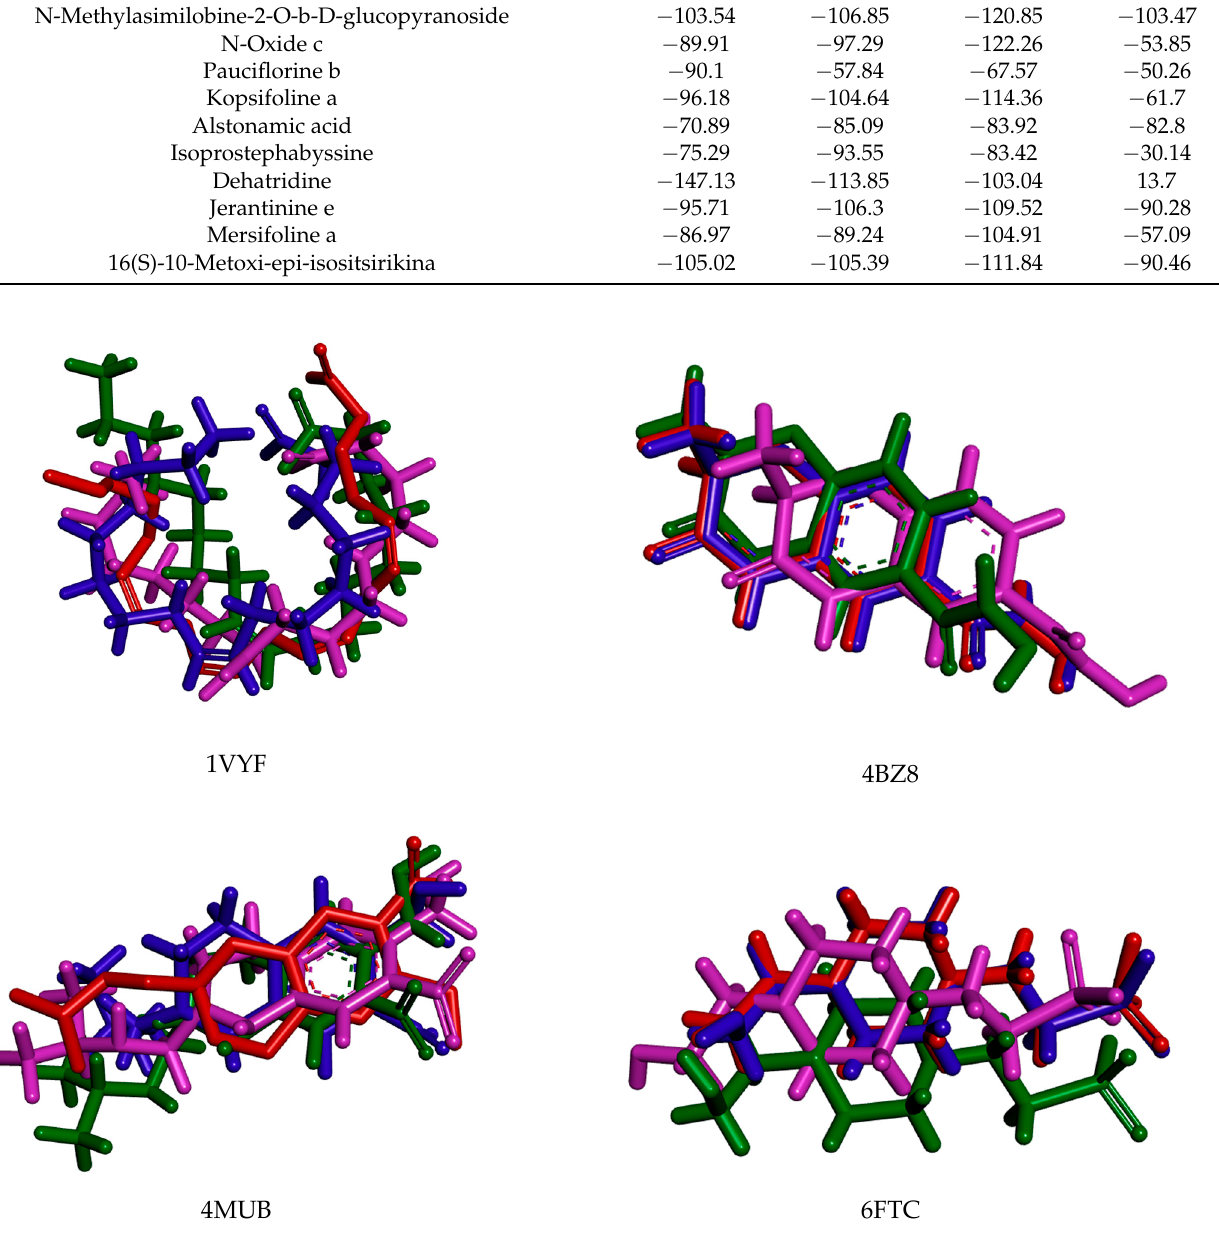
Figure A1. Redocked structures of PDB ligands in the active site of each studied protein. The red represents the cocrystal ligand, the blue represents the best pose for redocking, the pink represents the second-best pose for redocking, and the green represents the third-best pose for redocking.